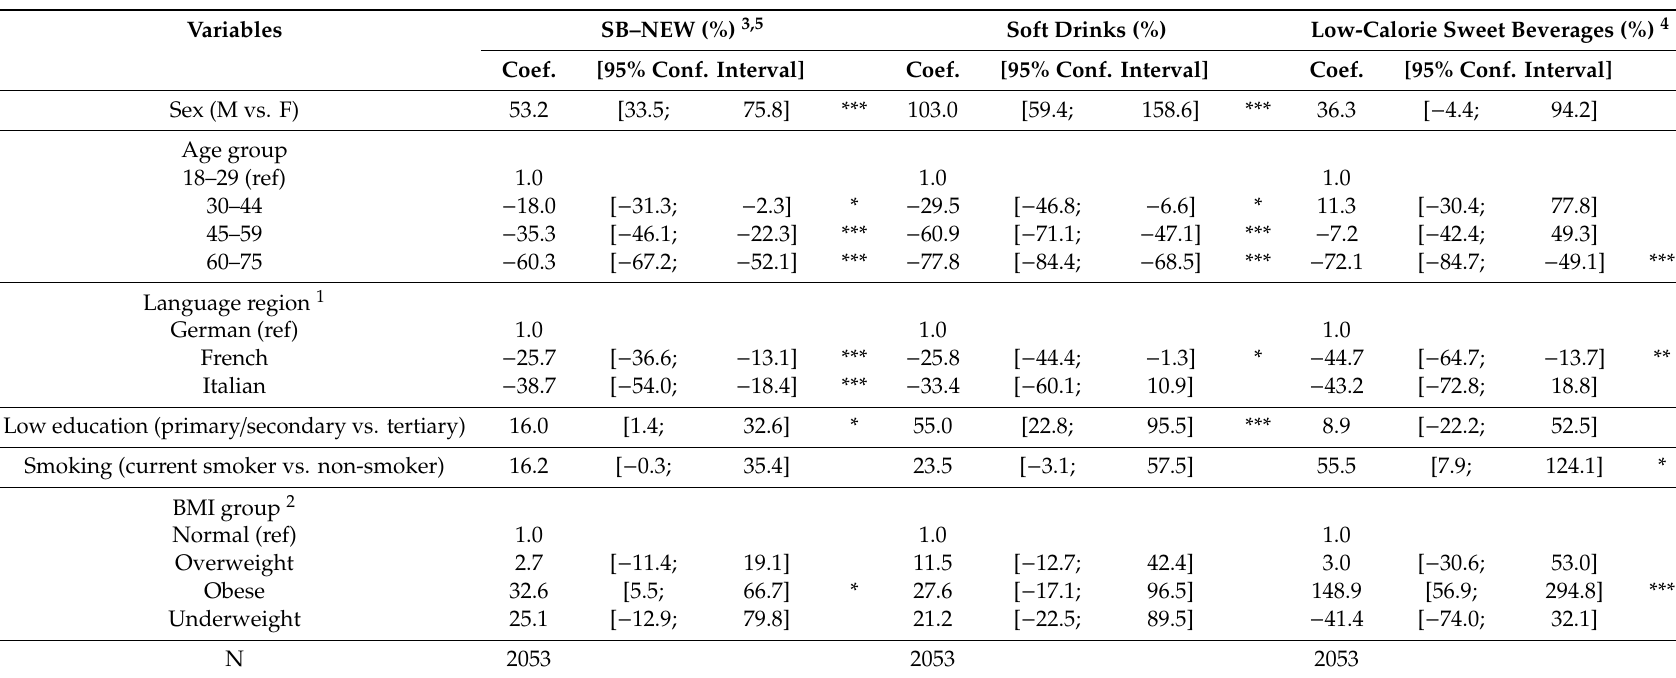
Table 3. Individual sociodemographic correlates of sweet beverage consumption for SB–NEW, soft drinks, and low-calorie sweet beverages.